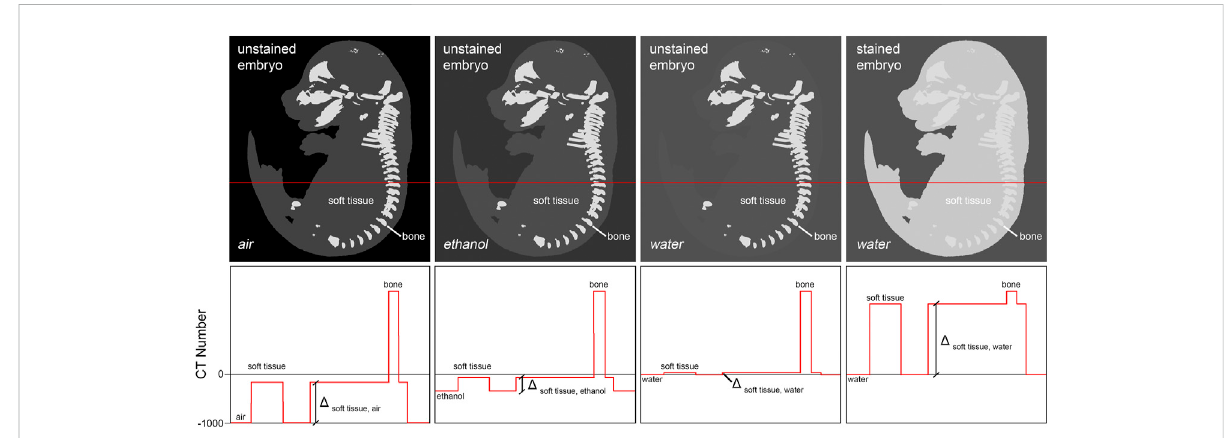
FIGURE 2 AchievingsofttissuecontrastinmicroCTimaging.Fixedbutotherwiseuntreated,non-mineralizedembryotissueshowsonlylittledifferencein x-rayattenuationtoaqueous mounting media. Thus, itsimaging inaqueousmedia isnotapplicable.Onepossibilitytoincrease softtissuecontrastis in fi ltrationofthetissuewithacontrastagentcontainingahighatomicnumber(Z)compound,thusincreasingX-rayattenuationoftissuerelativelyto the mounting medium ( ‘ staining ’ ). Alternatively, it is possible to decrease X-ray attenuation in the mounting medium by replacing water with ethanol or paraf fi n, or by drying the embryo followed by imaging of the sample in air. Of all approaches, staining typically yields highest soft tissue